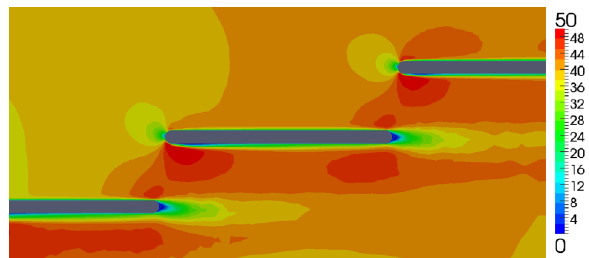
Fig. 5. Computed steady velocity field